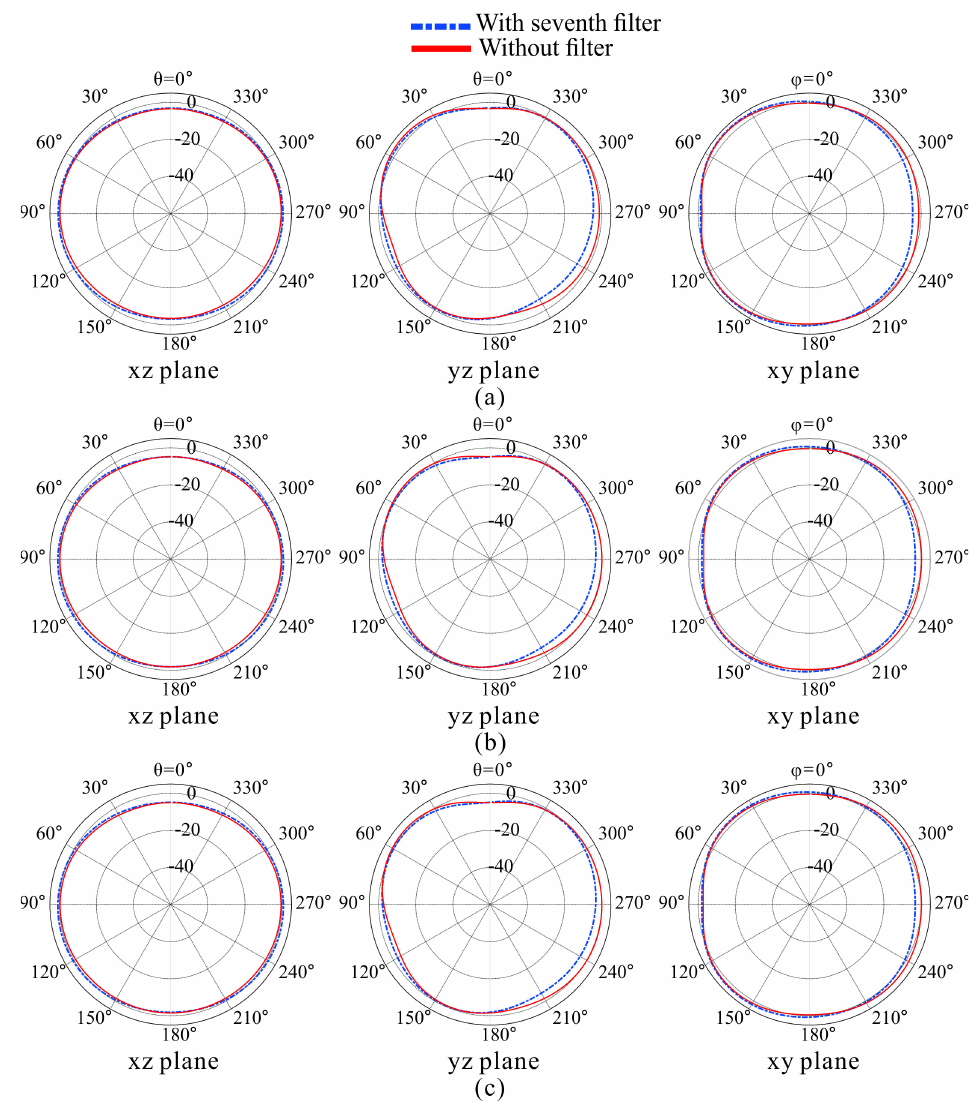
Figure 8. Simulated radiation pattern with and without filter: ( a ) 3.1, ( b ) 3.13, and ( c ) 3.15 GHz.